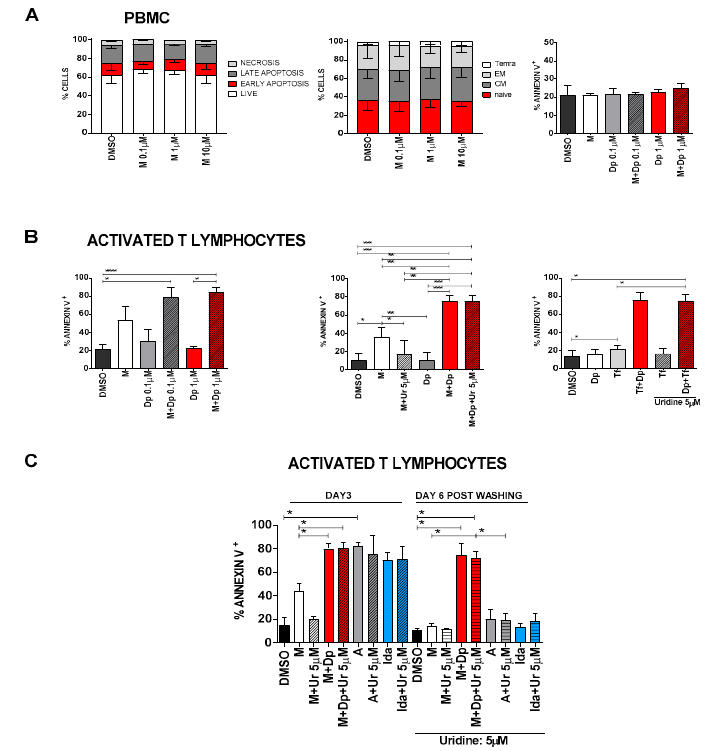
Figure 10. Toxicity of DHODH inhibitors alone and in combination with dipyridamole. ( A ) Left panel: apoptosis distribution induced by MEDS433 on PBMC, based on annexin V vs. propidium iodide expression ( n = 3). Middle panel: differentiation of T-lymphocytes treated with MEDS433 at increasing concentrations ( n = 3); the analysis was performed on the CD3+ population, identifying the following subsets: naïve (CD45RA + CD62L+), CM (central memory: CD45RA-CD62L+), EM (effector memory: CD45RA-CD62L-), and Temra (terminally differentiated effector memory CD45RA + CD62L-). Right panel: apoptosis induced by MEDS433 at 0.1 µ M, dipyridamole and their combination on PBMC ( n = 3). ( B ) Apoptosis induced by MEDS433 alone (0.1 µ M) or in combination with dipyridamole on activated T-lymphocytes, without (left panel, n = 3) or in the presence of uridine at the physiological concentration of 5 µ M (middle panel, n = 3). The same experiment was performed by replacing MEDS433 with Teriflunomide 100 µ M (right panel, n = 3). ( C ) Comparison between the long and short-term toxicity of MEDS433 (0.1 µ M) vs. chemotherapy (Idarubicin or Ara-c) on activated T-lymphocytes. The cells were treated for 3 days with MEDS433 alone and in combination with dipyridamole, or with Ara-C or idarubicin. After 3 days, cells were washed and replated without drugs, in the presence of physiological uridine concentrations (5 µ M). If not otherwise specified, apoptosis was evaluated after 3 days of treatment. PBMC: peripheral blood mononuclear